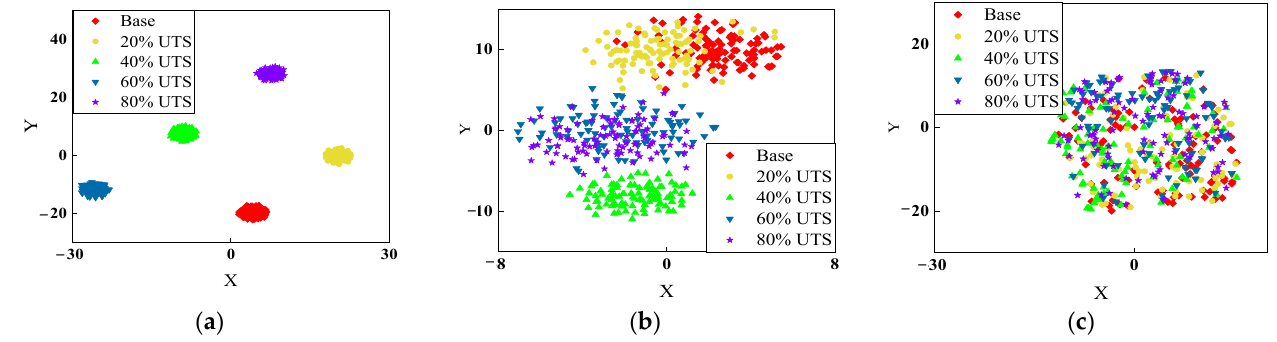
Figure 10. Feature visualization by t -SNE. ( a ) SNR = 100 dB; ( b ) SNR = 70 dB; ( c ) SNR = 60 dB.